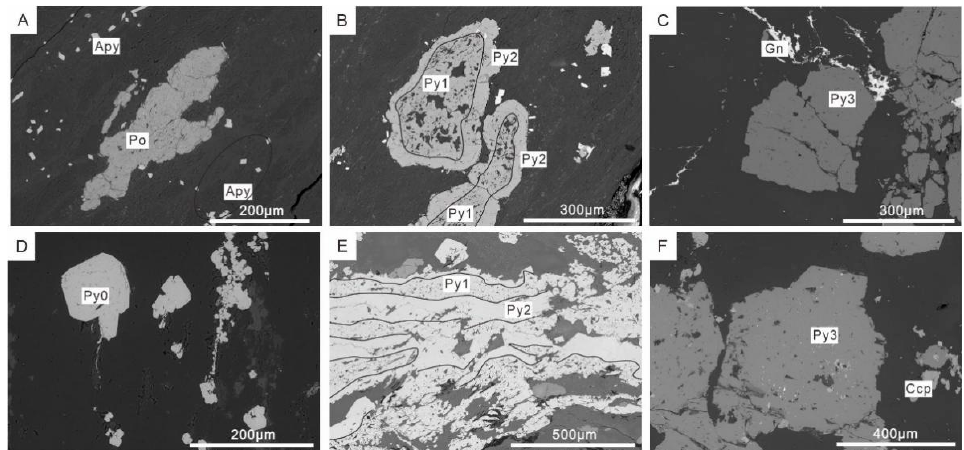
Figure 9. BSE images of sulfides of each stage. ( A ) Pyrrhotite in the schist of wall rock; ( B ) Rough and porous Py1 was contained by smooth Py2 in the Hongqigou deposit; ( C ) Py3 coexist with galena in stage 3 in the Hongqigou deposit; ( D ) Py0 in ultra-mylonite; ( E ) Rough and porous Py1 was contained by smooth Py2 in the Huanglonggou deposit; ( F ) Py3 coexist with chalcopyrite in stage 3 in the Huanglonggou deposit. Abbreviations: Apy = arsenopyrite, Ccp = chalcopyrite, Gn = galena, Po = pyrrhotite, Py = pyrite.